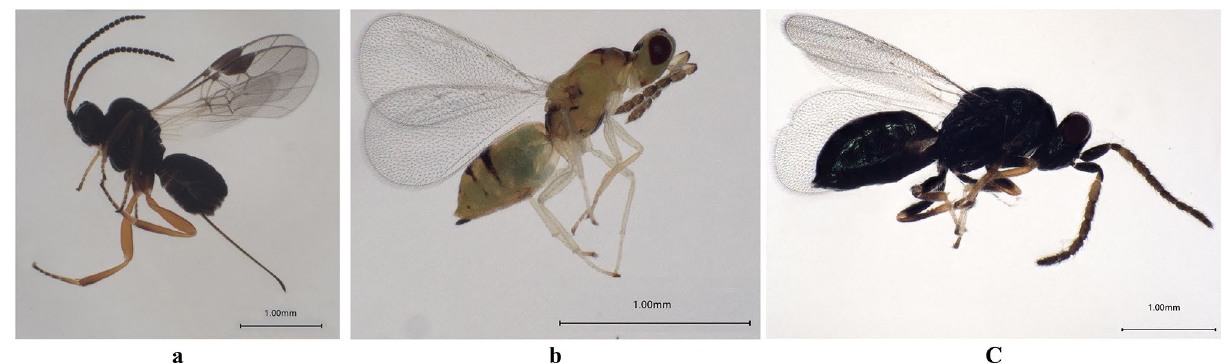
Figure 10. Three species of parasitoids cultivated from mature larvae of Rhynchaenus maculosus . ( a ) Braconidae sp. collected in Liaoning; ( b ) Eulophidae sp. collected in Liaoning; ( c ) Ceraphronidae sp. collected in Jilin and